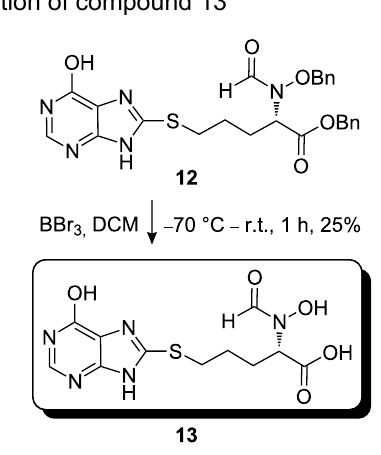
Compound 13: To a mixture of compound 12 (30.0 mg) and DCM (10.0 mL) at − 70 o C, was added a solution of BBr 3 (130.0 mg) in DCM (1.0 mL). The mixture was allowed to warm to room temperature, stirred for one additional hour and then poured into iced-water. The aqueous layer was washed with dichloromethane and adjusted to pH 3–4. The remaining aqueous solution was concentrated in vacuum, and the residue was washed with THF. The THF layer was concentrated and purified by preparative HPLC to give the product (5.0 mg, 25%). 1 H NMR (400 MHz, CDCl 3 ): δ 12.80 (brs, 1H), 12.21